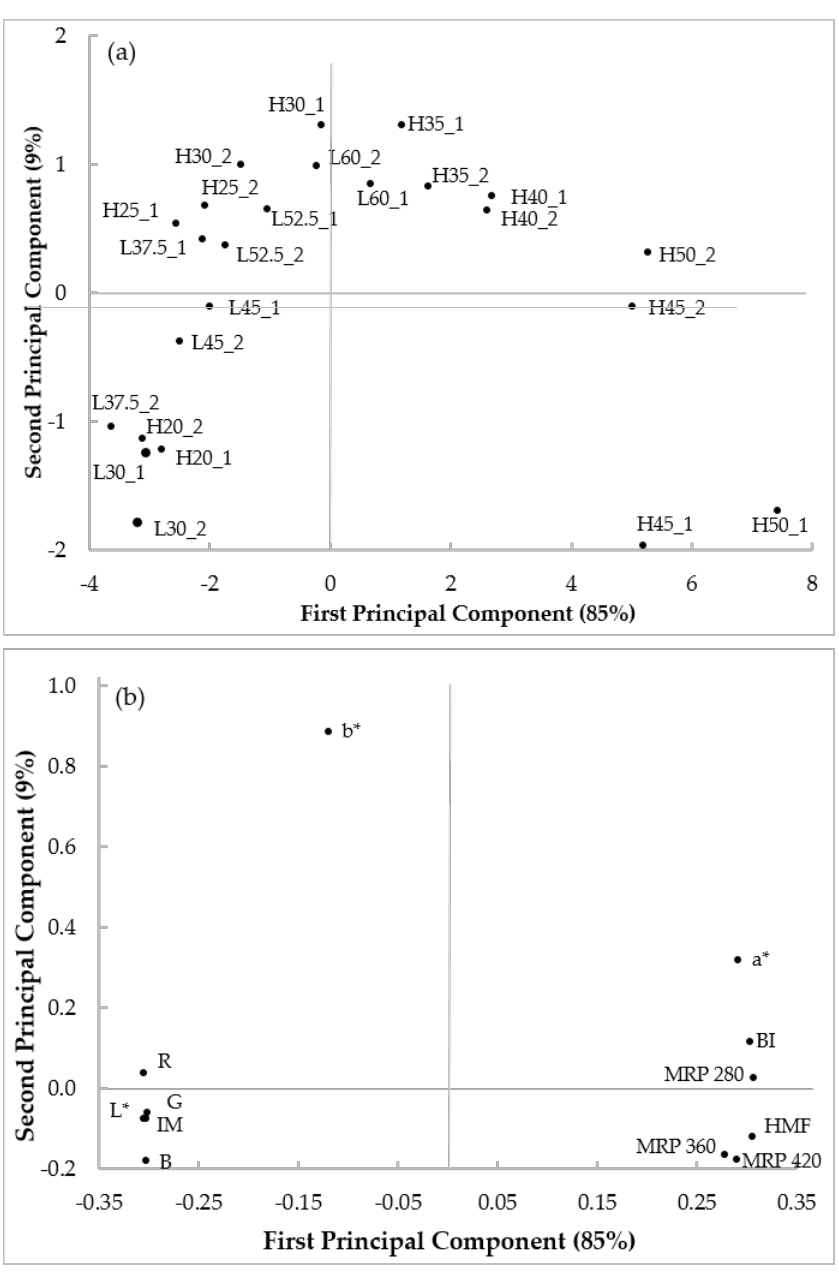
Figure 6. Principal component analysis score plot ( a ) and loadings plot ( b ) of bread browning, HMF and Maillard reaction product (MRP) data collected on bread samples baked at 200 °C and 225 °C for different baking times. For sample identification see (Table 1); a*, redness; b*, yellowness; B, density blue; BI, browning index; G, density green; HMF, 5-hydroxymethylfurfural; IM, Intensity mean; L*, lightness; MRP 280, Maillard reaction products evaluated at 280 nm; MRP 360, Maillard reaction products evaluated at 360 nm; MRP 420, Maillard reaction products evaluated at 420 nm; R, density red.